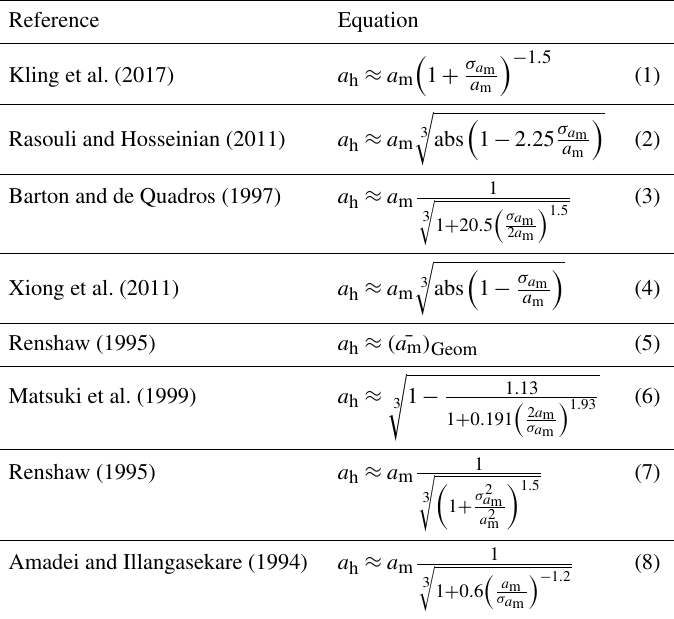
Table 1. Equations for estimating the hydraulic fracture aperture based on the mean mechanical fracture aperture and the standard deviation of measured distance values along a fracture